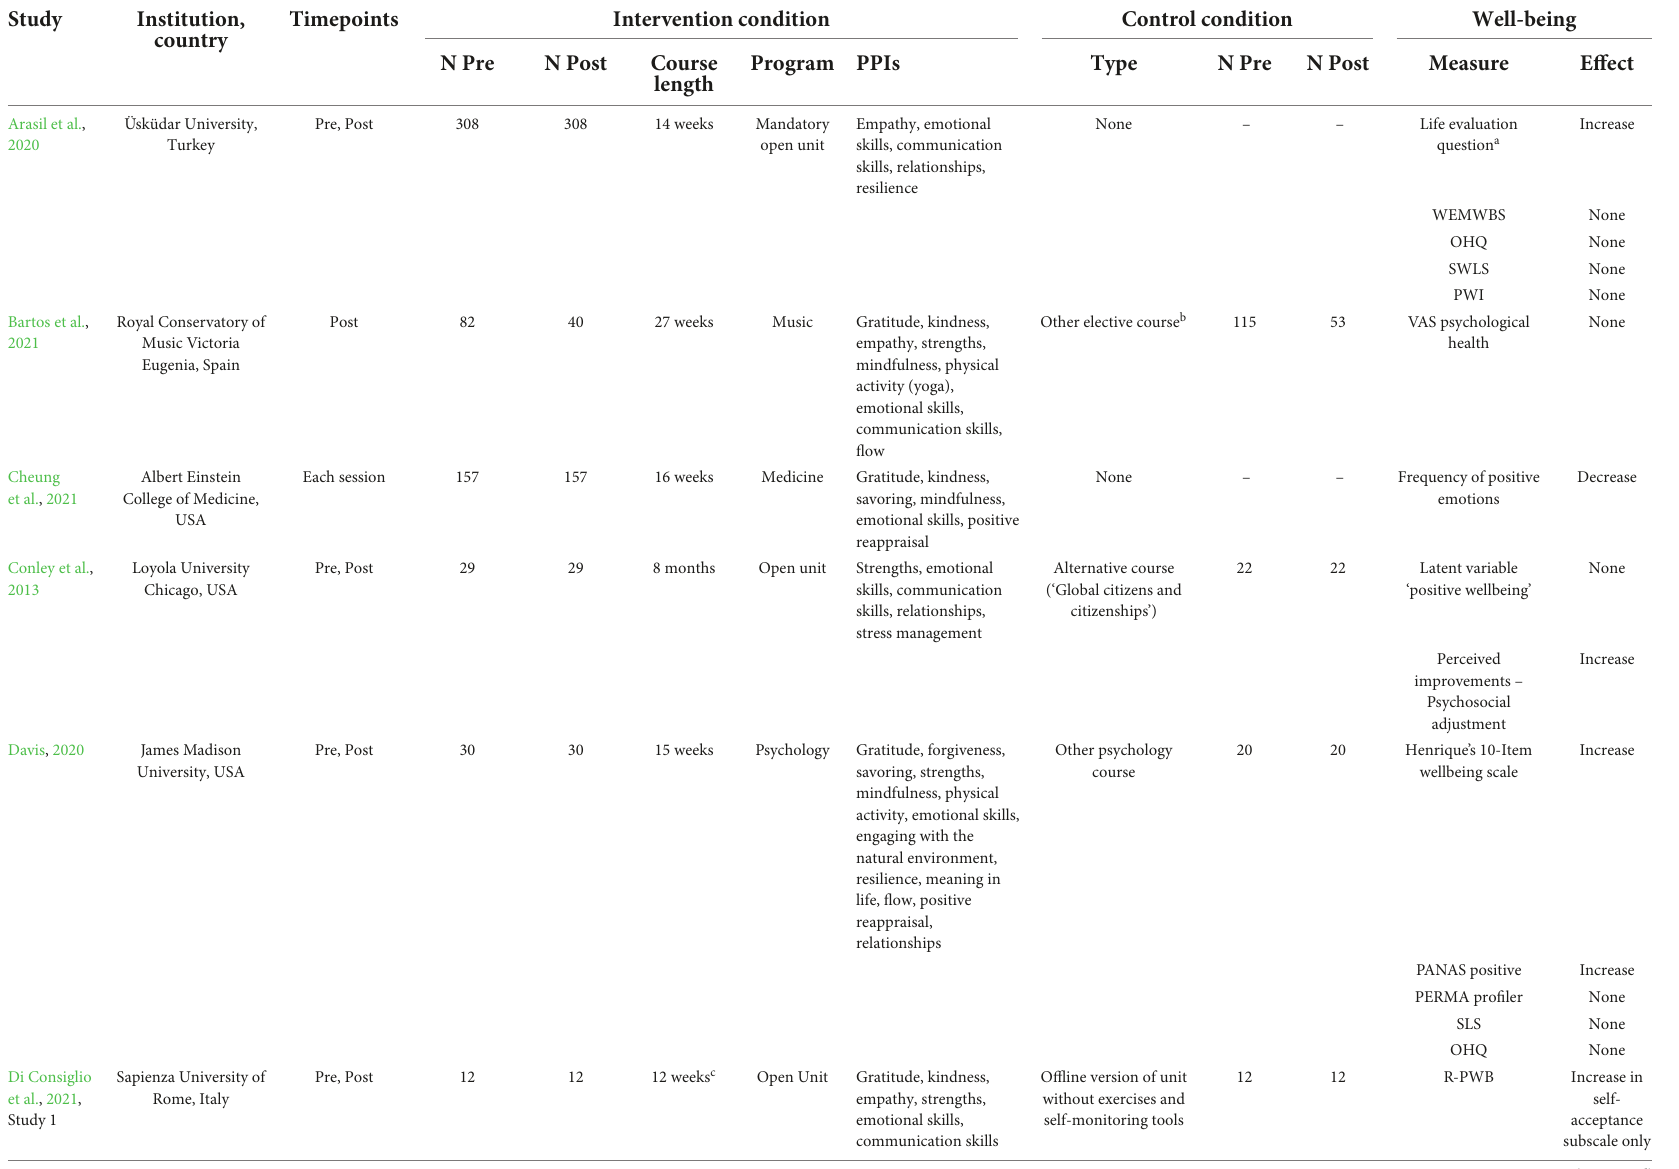
TABLE 1 Study characteristics and reported effects of interventions on